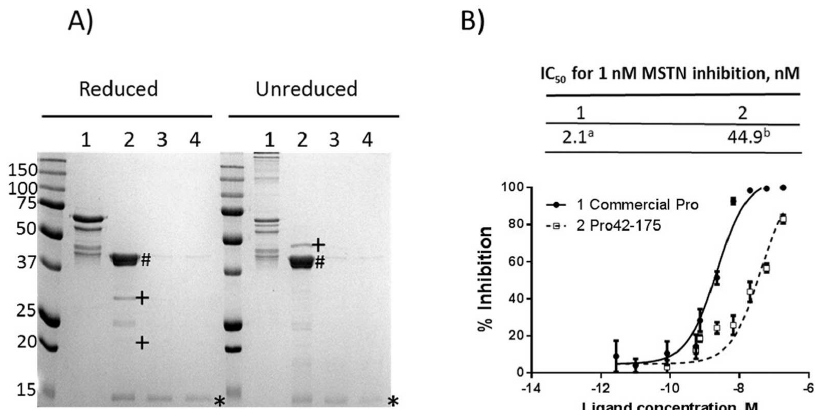
Fig 6. SDS-PAGE analysis of MBP-Pro42-175 after factor Xa cleavage and examination of MSTN- inhibitory capacityof Pro42-175. (A) After incubationof MBP-Pro42-175with factor Xa, the supernatant was subjected to amyloseaffinity purification, followedby removal of factor Xa usinga factor Xa affinity column. Proteinsamplescollectedduringthe cleavageandpurificationsteps were subjected to 15%SDS-PAGE analysis,and visualizedwith Coomassieblue staining.Lane1, MBP-Pro42-175; lane 2, MBP-Pro42-175 digestedwith factor Xa; lane 3, Pro42-175 purifiedby amyloseaffinity; lane 4, Pro42-175with factor Xa being removed;#, MBP; +, factor Xa (disulfidelinkedheterodimer under non-reduced condition); * , Pro42-175. (B) MSTN-inhibitory capacityof purifiedPro42-175 was measured usingthe (CAGA) 12 -luciferase reporter gene assay. The meansof IC 50 not sharingthe same superscript are different at P < 0.05.